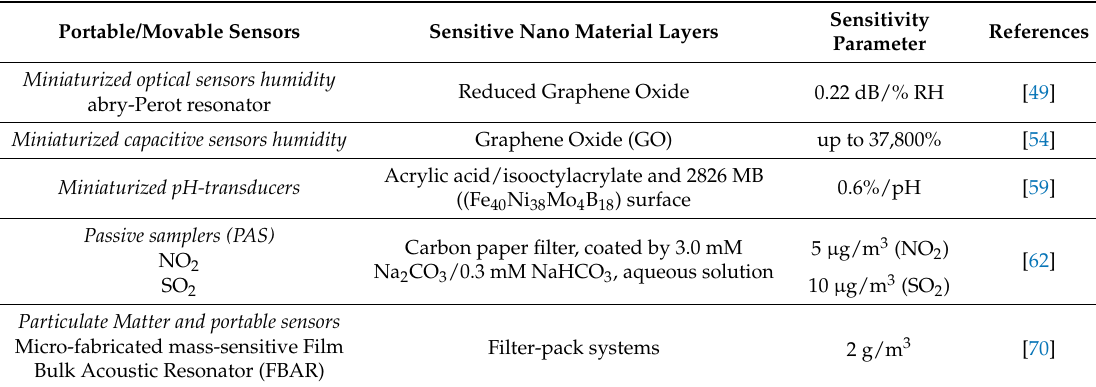
Table 2. Comparison in terms of the sensitivity for the most performing